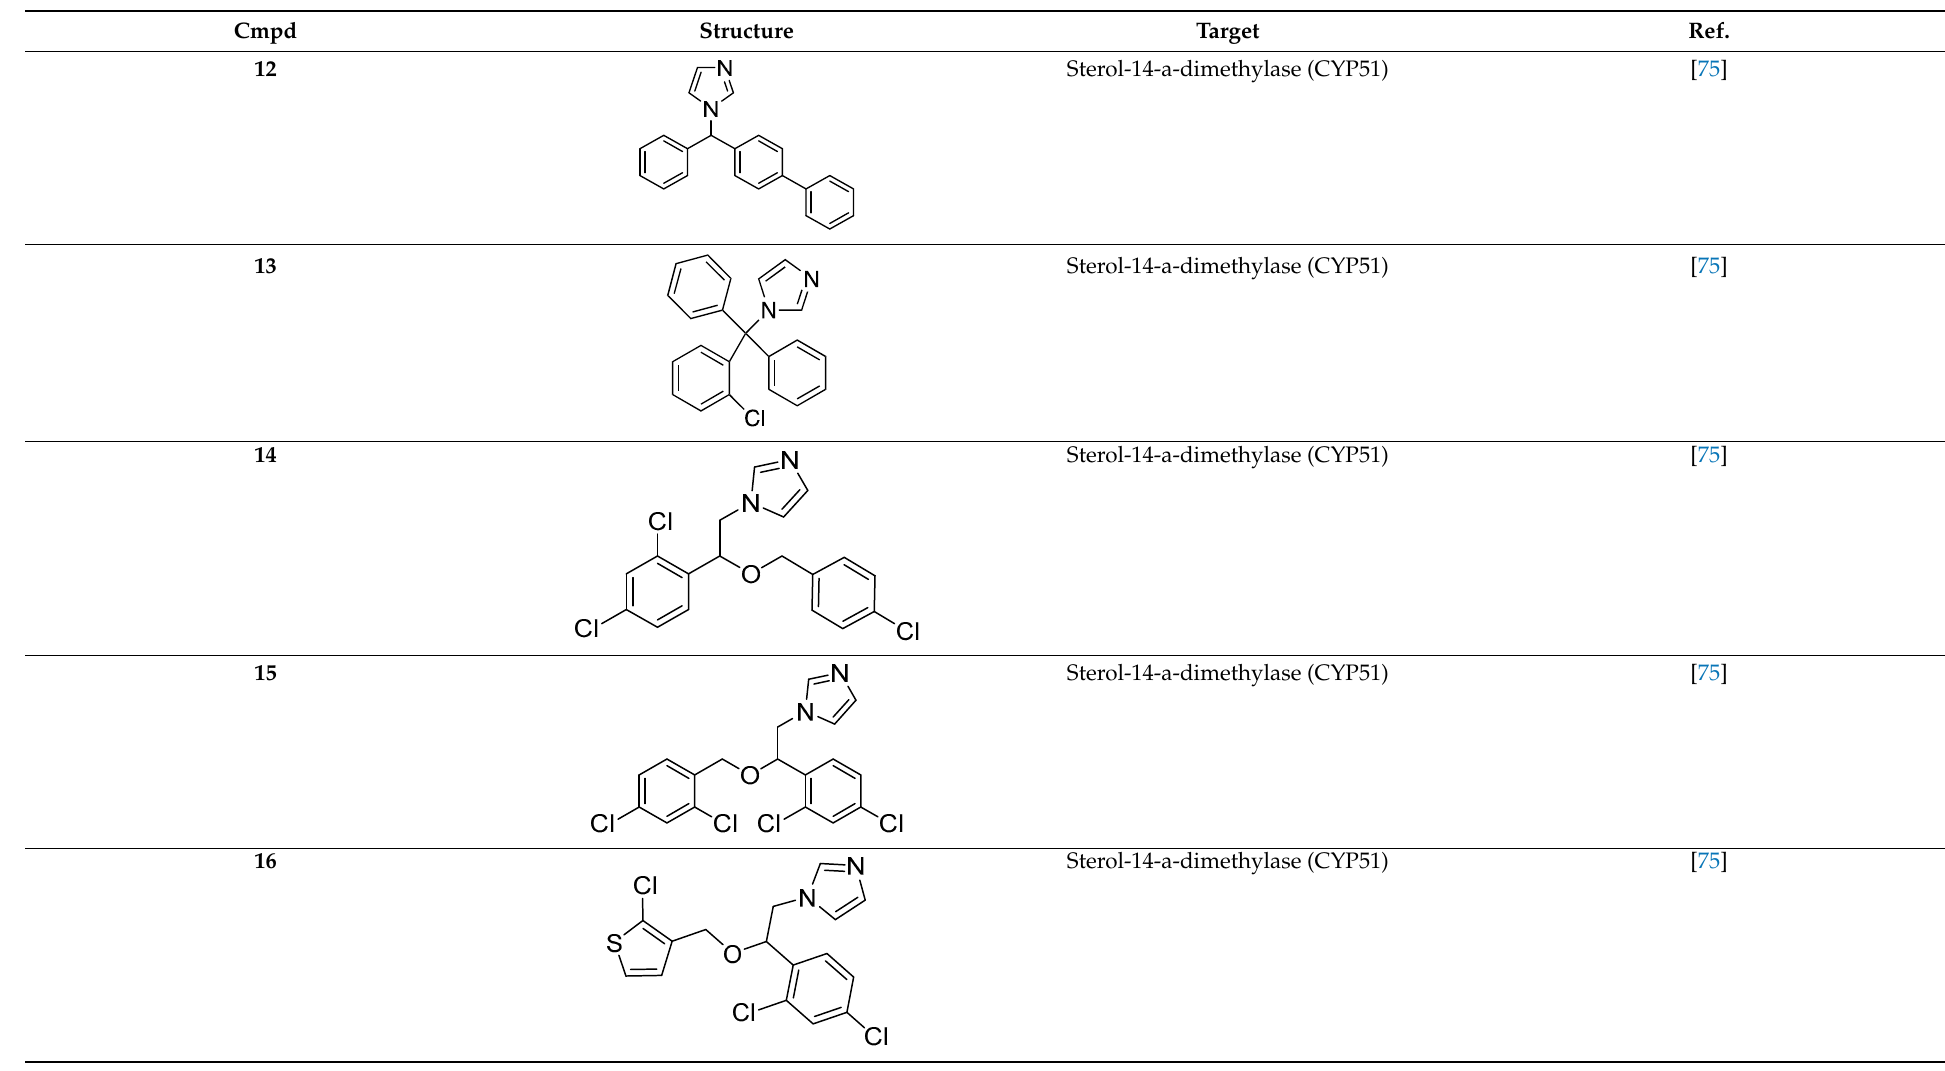
Table 4. Targets and related agents against CD.